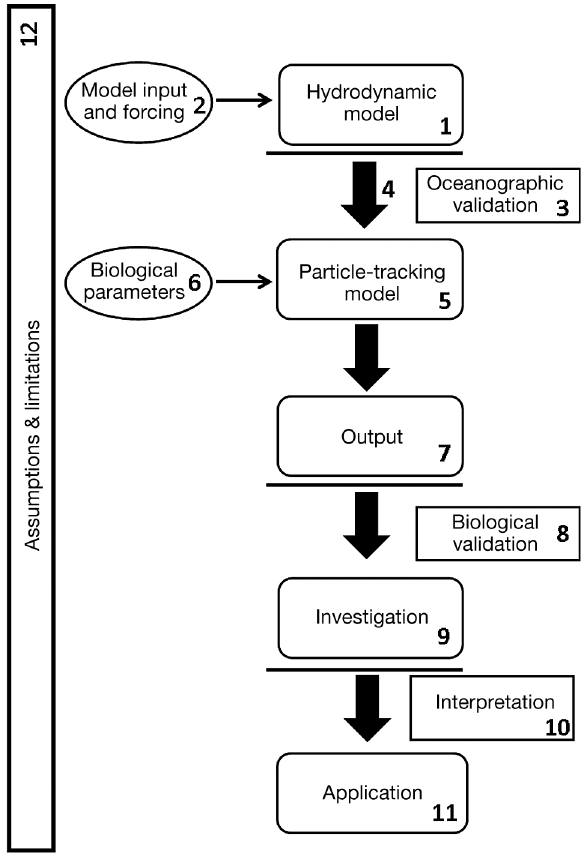
Fig. 1. Framework of components to develop methods for investigating the environmental transmission of disease- causing